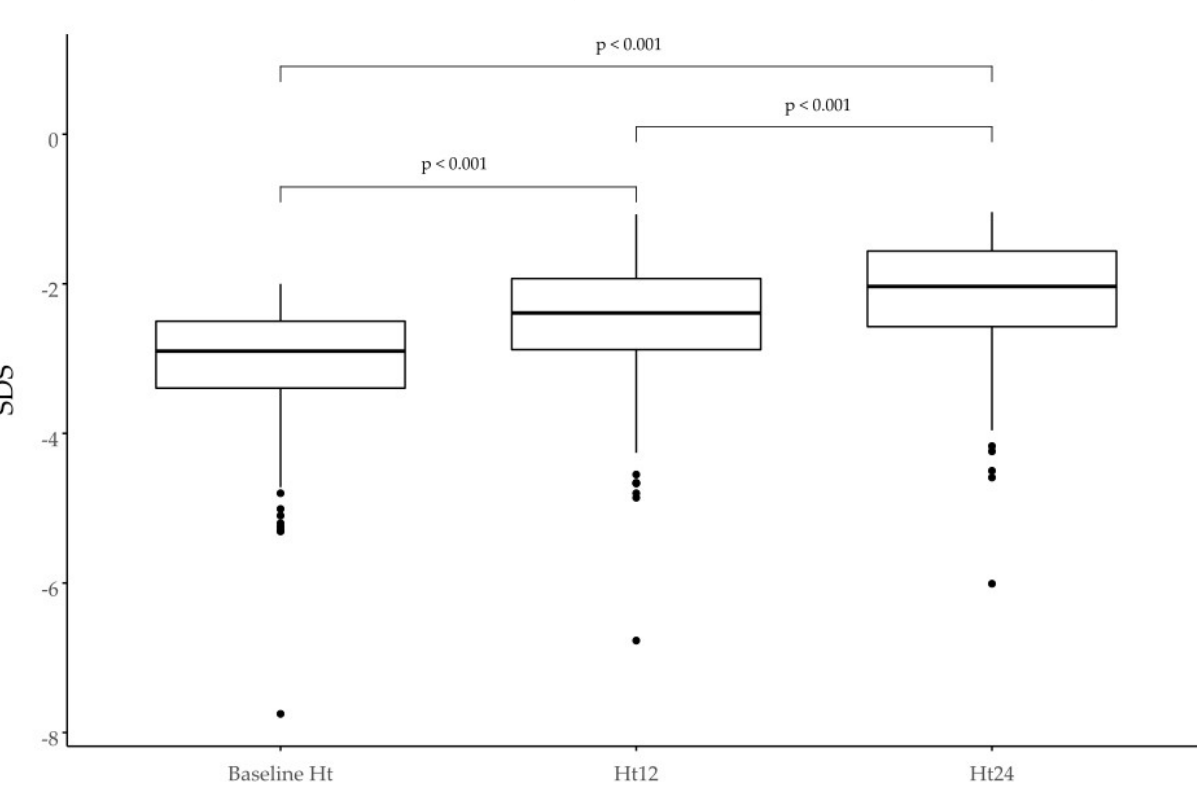
Figure 2. Growth in SGA children is expressed as the change in height (Ht) SD score at the baseline and after 12 and 24 months of treatment. Table 2. Selected growth parameters observed during the